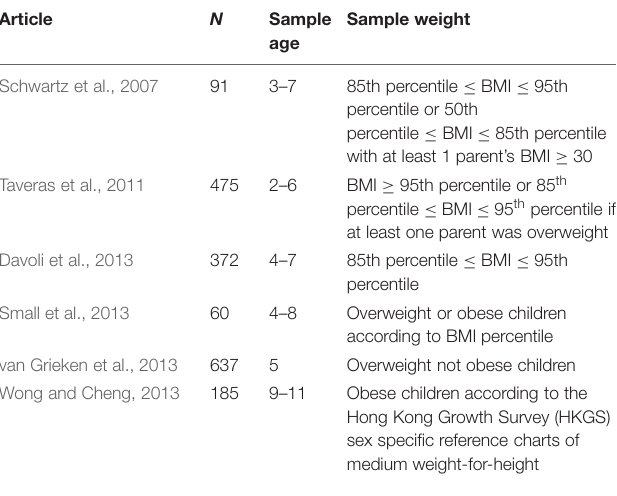
TABLE 1 | Selected article characteristics of the